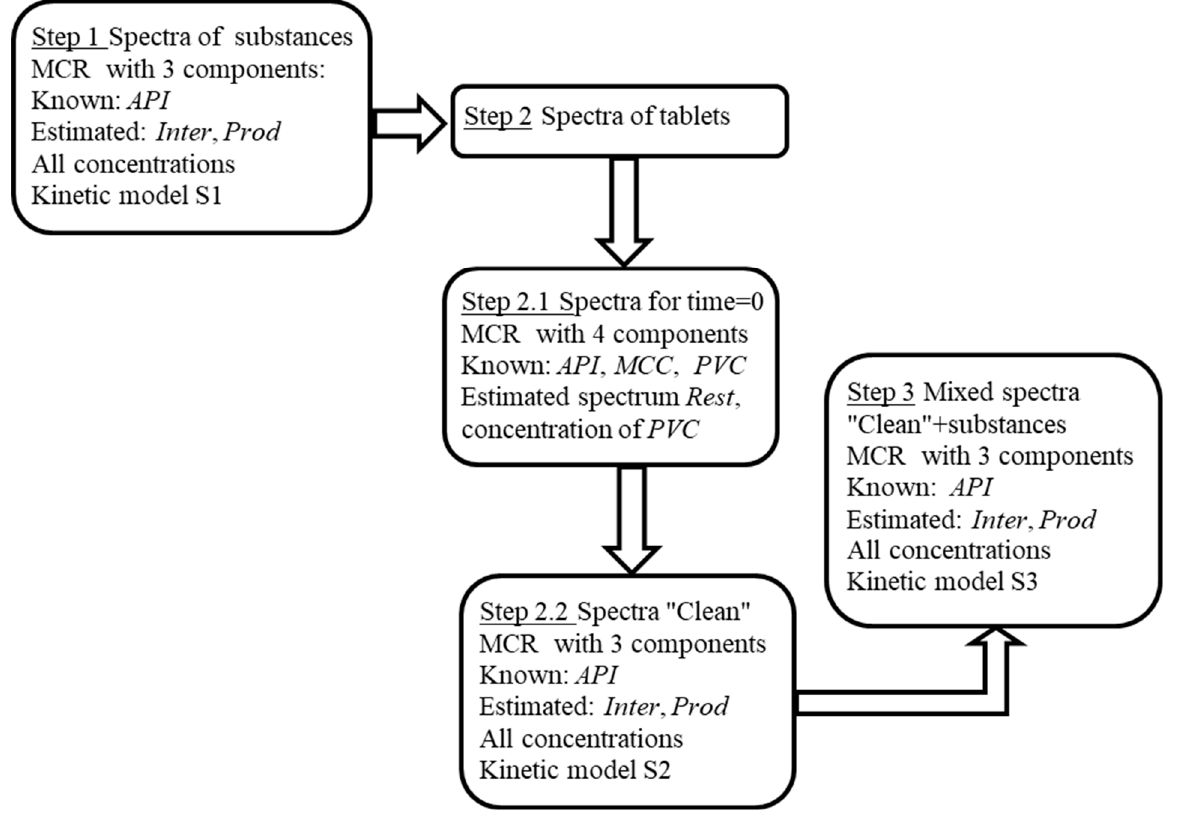
Figure 1. Scheme of multi-step MCR + Kinetics analysis.